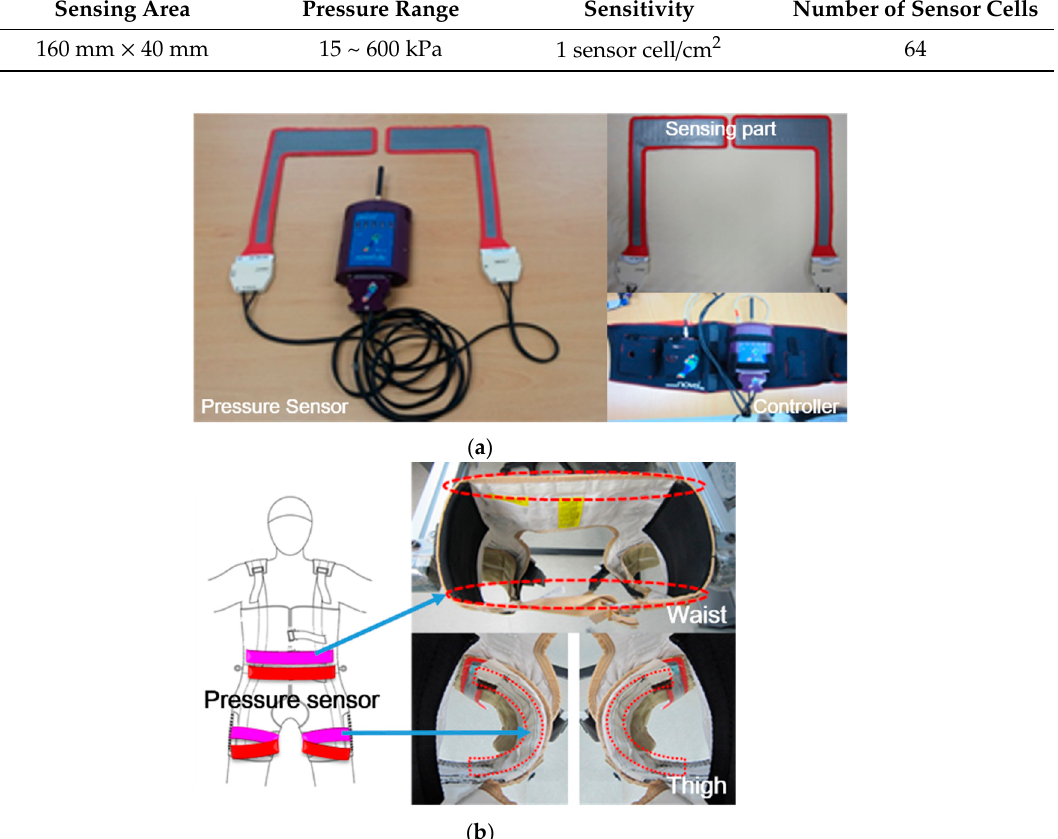
Table 2. Specification of pressure